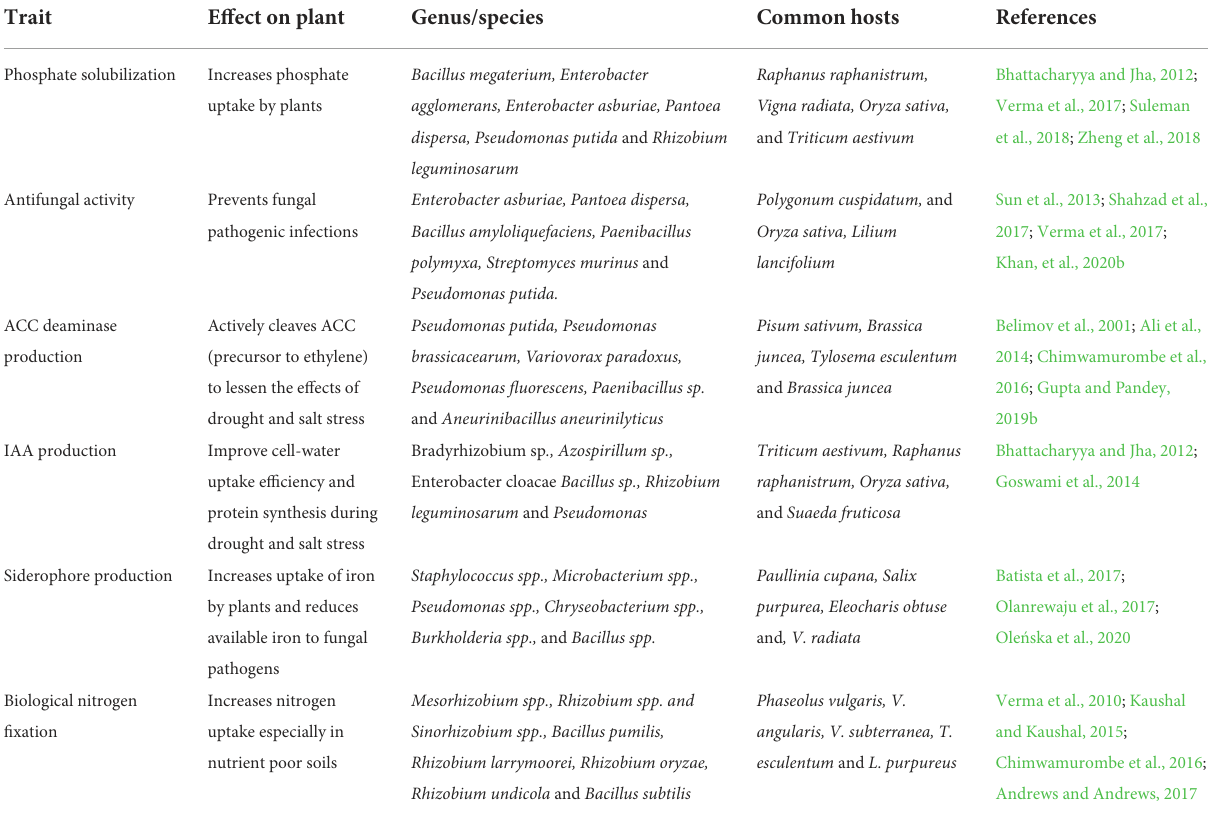
TABLE 1 Bacterial plant growth-promoting